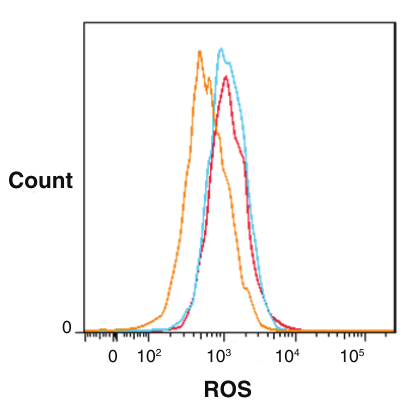
Figure 3. Flow cytometry analysis of the oxidative status of RBCs in the patient and a healthy donor. Peripheral blood mononuclear cells from the patient and a normal control were treated with the oxidation sensitive dye, CM-H2DCFDA, and the conversion to its oxidized fluorescent derivative assessed by flow cytometry. The fluorescence distribution histogram and the mean fluorescence channels (MFC) of each population derived from the normal control (orange) and the patient (blue for CD55 negative and red for CD55 positive cells) are shown. The figure shows a representative example of 4 normal controls that gave similar